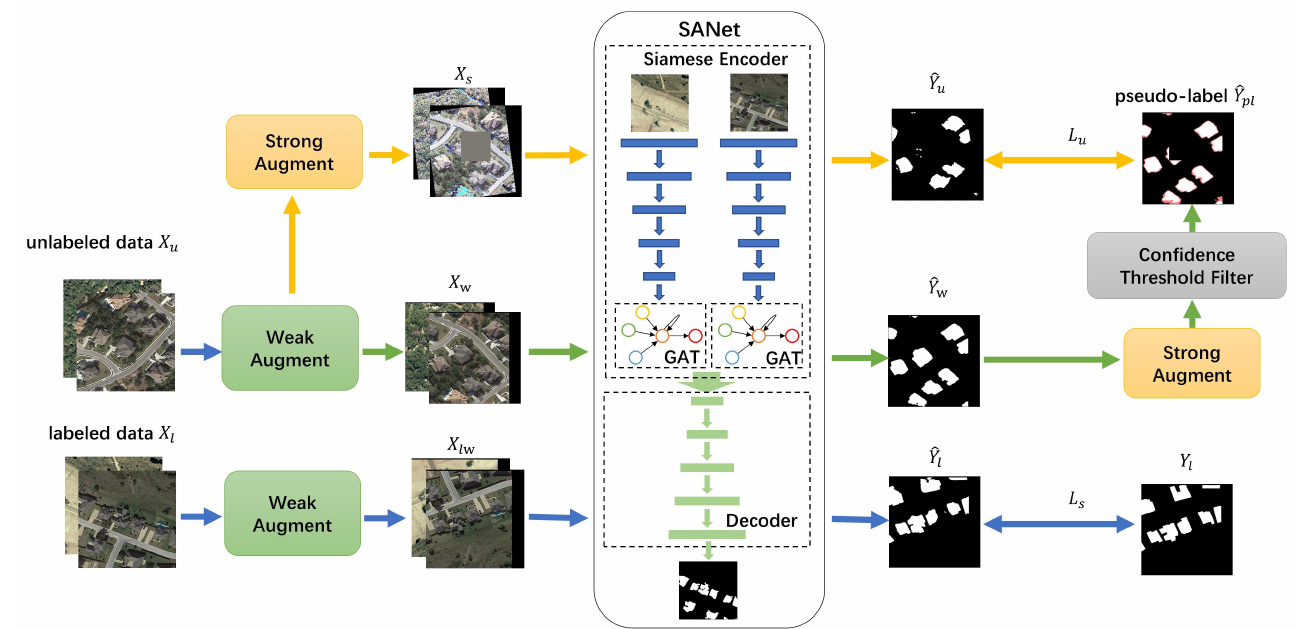
Figure 1. Flowchart of the method semiSANet. The labeled data are directly passed through the SANet after weak augmentation to obtain the fully supervised loss L s . The unlabeled data are fed into the SANet after weak augmentation (to obtain ˆ Y w ) and the confidence threshold filter to obtain the pseudo-label ˆ Y pl , at the same time using the strong augmentation to produce distorted image and obtain CD results ˆ Y u by the SANet. The unsupervised loss L u is calculated by ˆ Y u and ˆ Y pl